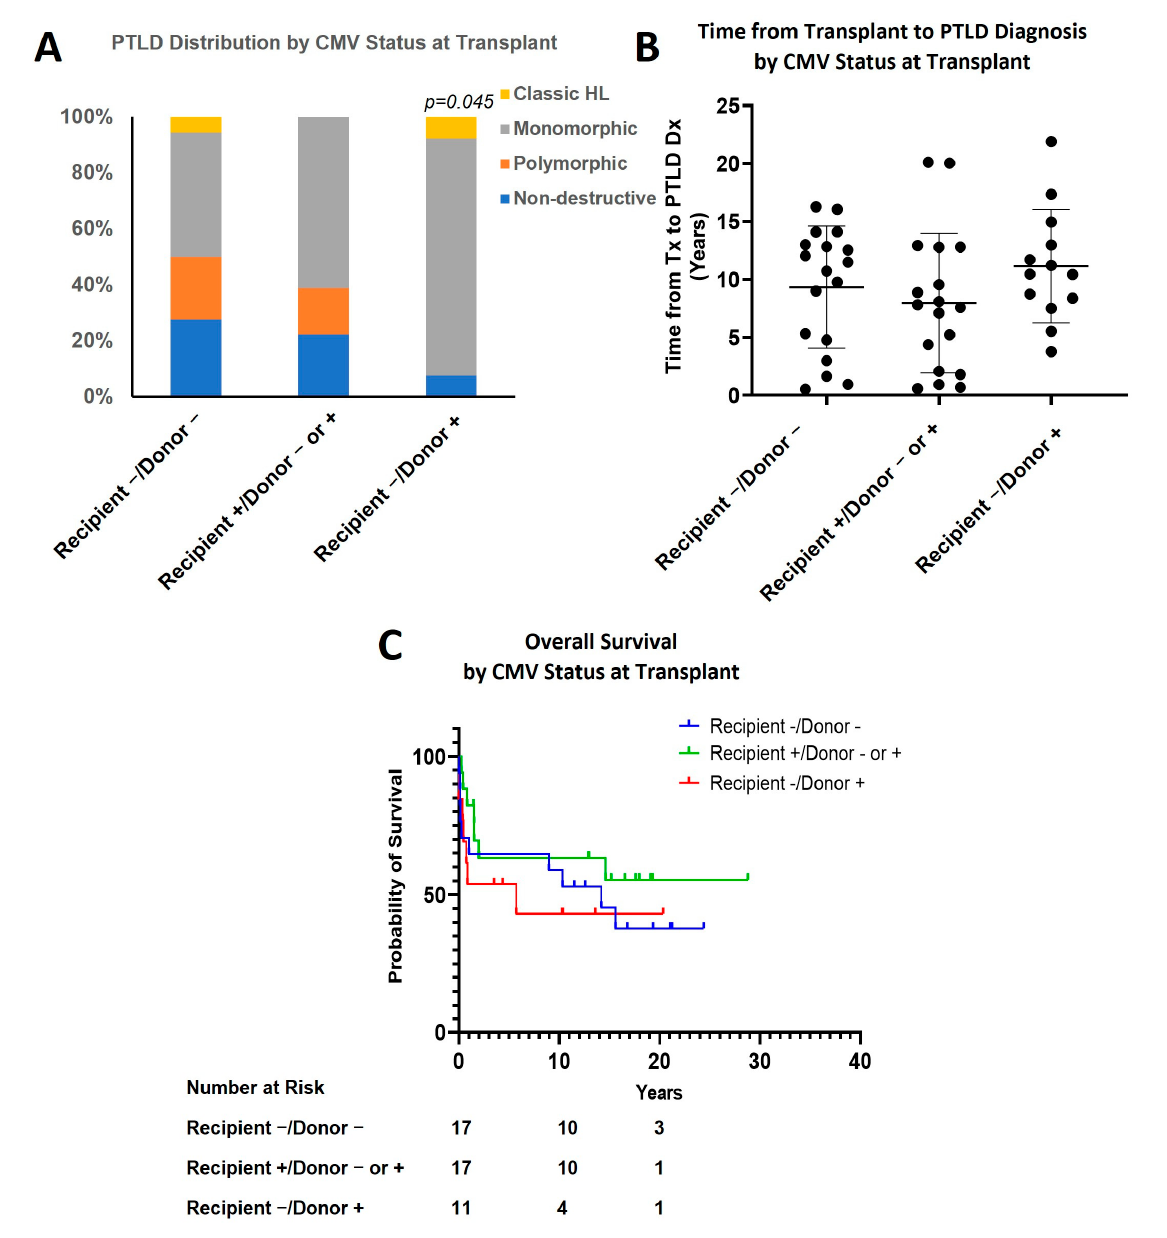
Figure 5. Effect of CMV status. ( A ) PTLD distribution by CMV status at transplant ( p = 0.045, recipient − /donor+ vs. combined other two groups); ( B ) Time from transplant to PTLD diagnosis by CMV status at transplant; ( C ) Overall survival by CMV status at transplant.